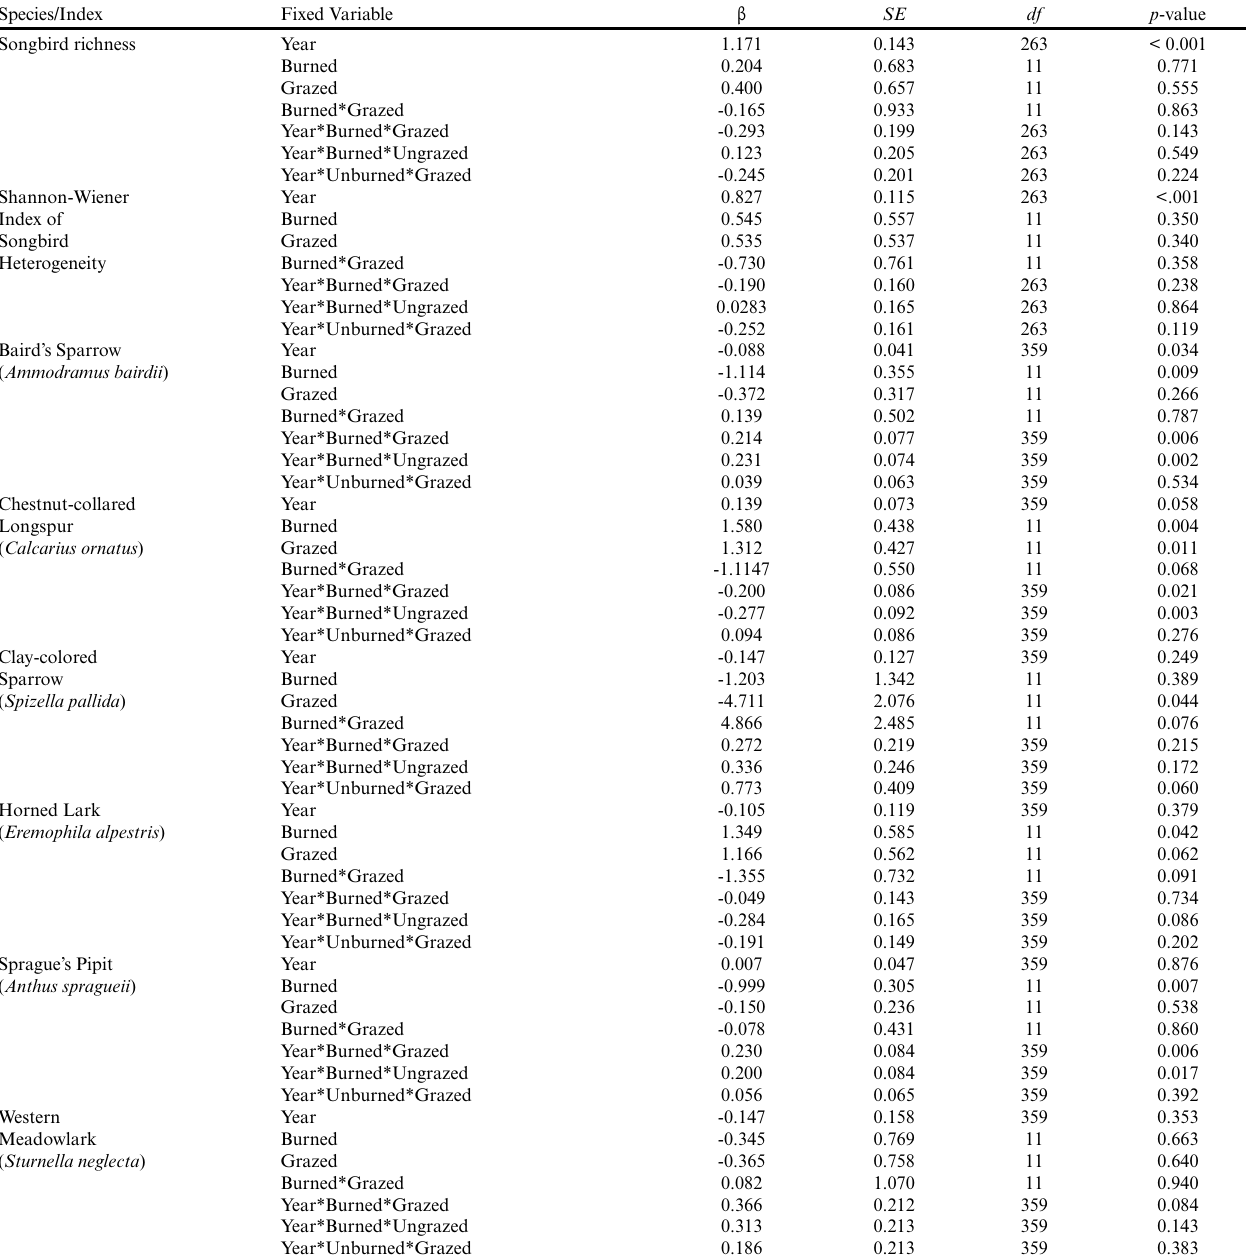
Table 1 . Interactions among year, burning, and grazing on songbird species abundances in Grasslands National Park of Canada from 2007 to 2011; slopes were compared against the slope for year*unburned*ungrazed when analyzing the interaction between year and treatment. For conciseness, only species that showed at least one significant result are